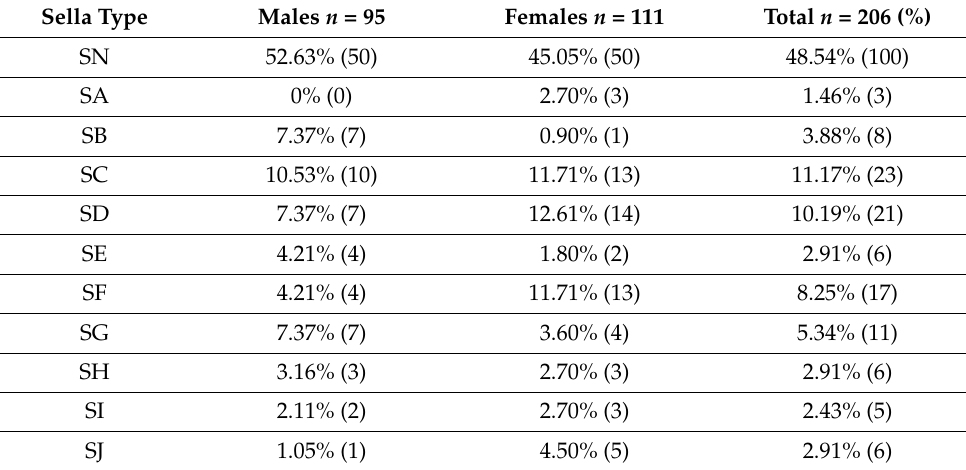
Table 2. Sella turcica types in the present study (%, n = 206).